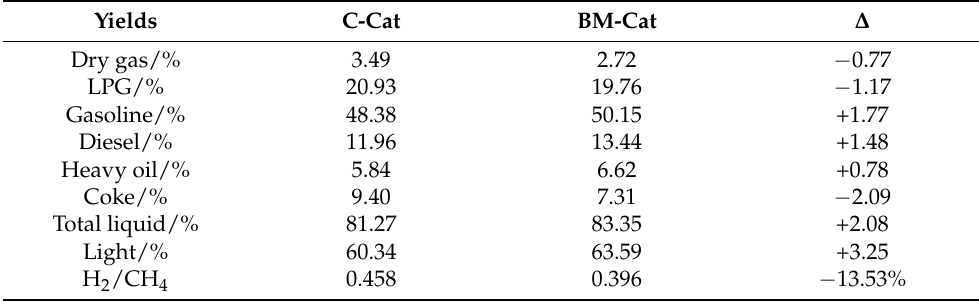
Figure 7. H 2 -TPR profiles of NiO and NiB 2 O 4 .